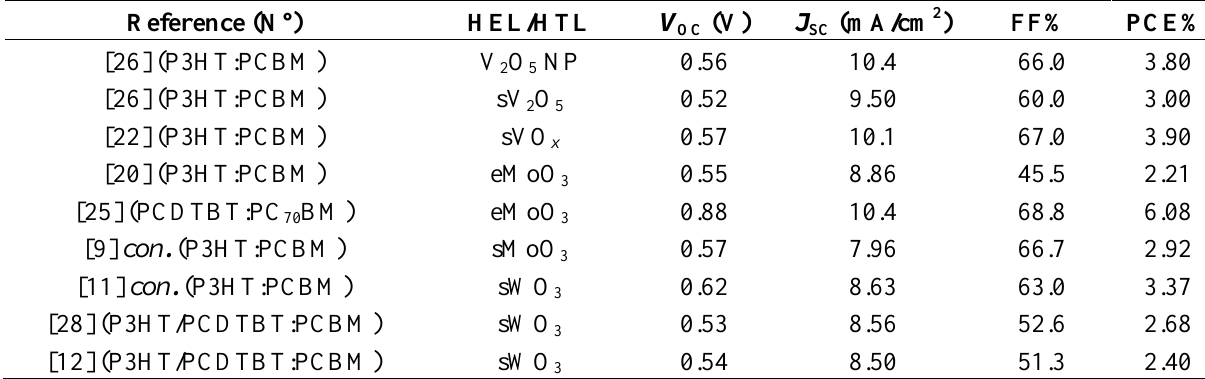
Table 2. Device parameters of i-BHJ solar cells with different hole transport/extraction interlayers. HEL, hole extraction layer; HTL, hole transport